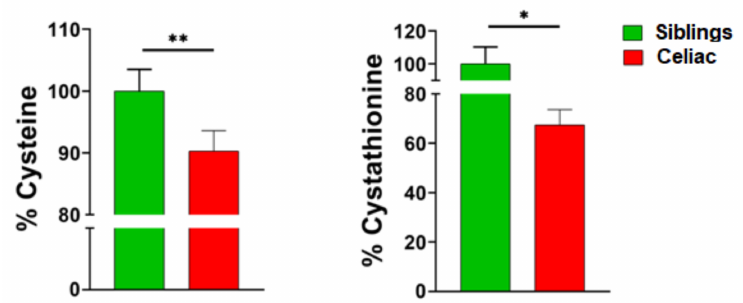
Figure 3. Plasma cysteine and cystathionine content is decreased in celiac disease children as compared to healthy siblings. * p < 0.05, ** p <